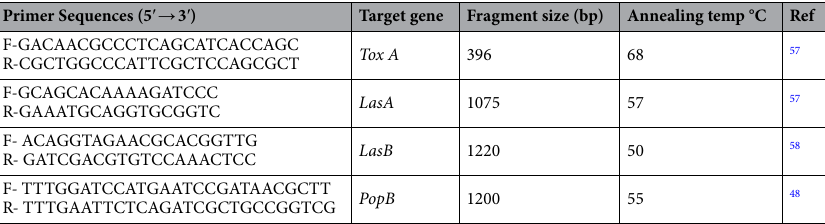
Primer Sequences (5 ′ → 3 ′